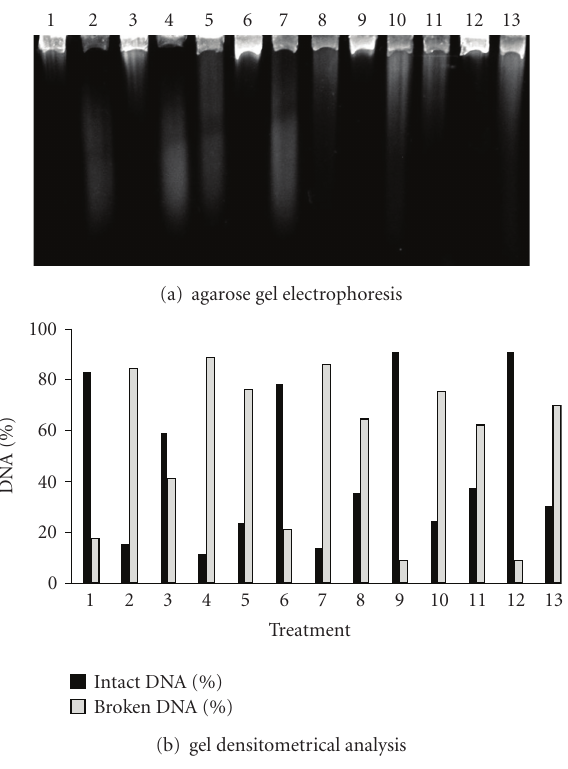
Figure 7: Alkaline gel electrophoresis of E. coli BW372 treated with SnCl 2 (25 μ g/mL), UVA (90kJ/m 2 ) and pre-illuminated with UVA, followed by SnCl 2 incubation. Lanes: (1) control; (2) SnCl 2 ; (3) UVA; (4) UVA + SnCl 2 ; (5) SnCl 2 30 minutes; (6) UVA 30 minutes; (7) UVA + SnCl 2 30 minutes; (8) SnCl 2 60 minutes; (9) UVA 60 minutes; (10) UVA + SnCl 2 60 minutes; (11) SnCl 2 90 minutes; (12) UVA 90 minutes; (13) UVA + SnCl 2 90 minutes.